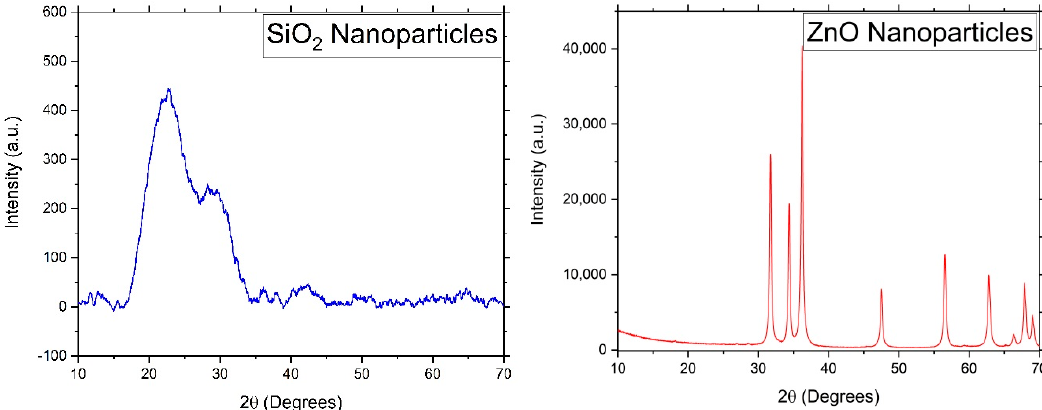
Figure 2. X-ray diffraction (XRD) patterns of pristine silica ( left ) and ZnO ( right ) nanoparticles. Figure 2. X-ray di ff raction (XRD) patterns of pristine silica ( left ) and ZnO ( right )